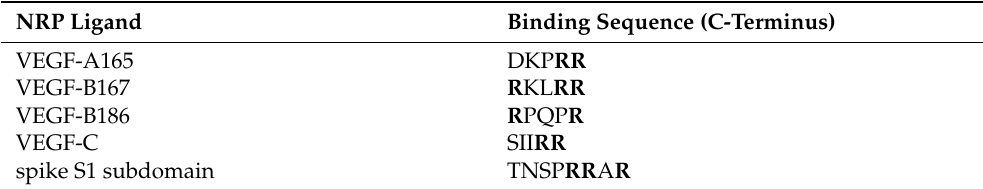
Table 2. Amino acid sequences of VEGF members and isoforms and SARS-CoV-2 S1 subdomain predicted to bind to the B1 domain of NRPs. Abbreviations: NRP: neuropilin; VEGF: vascular endothelial growth